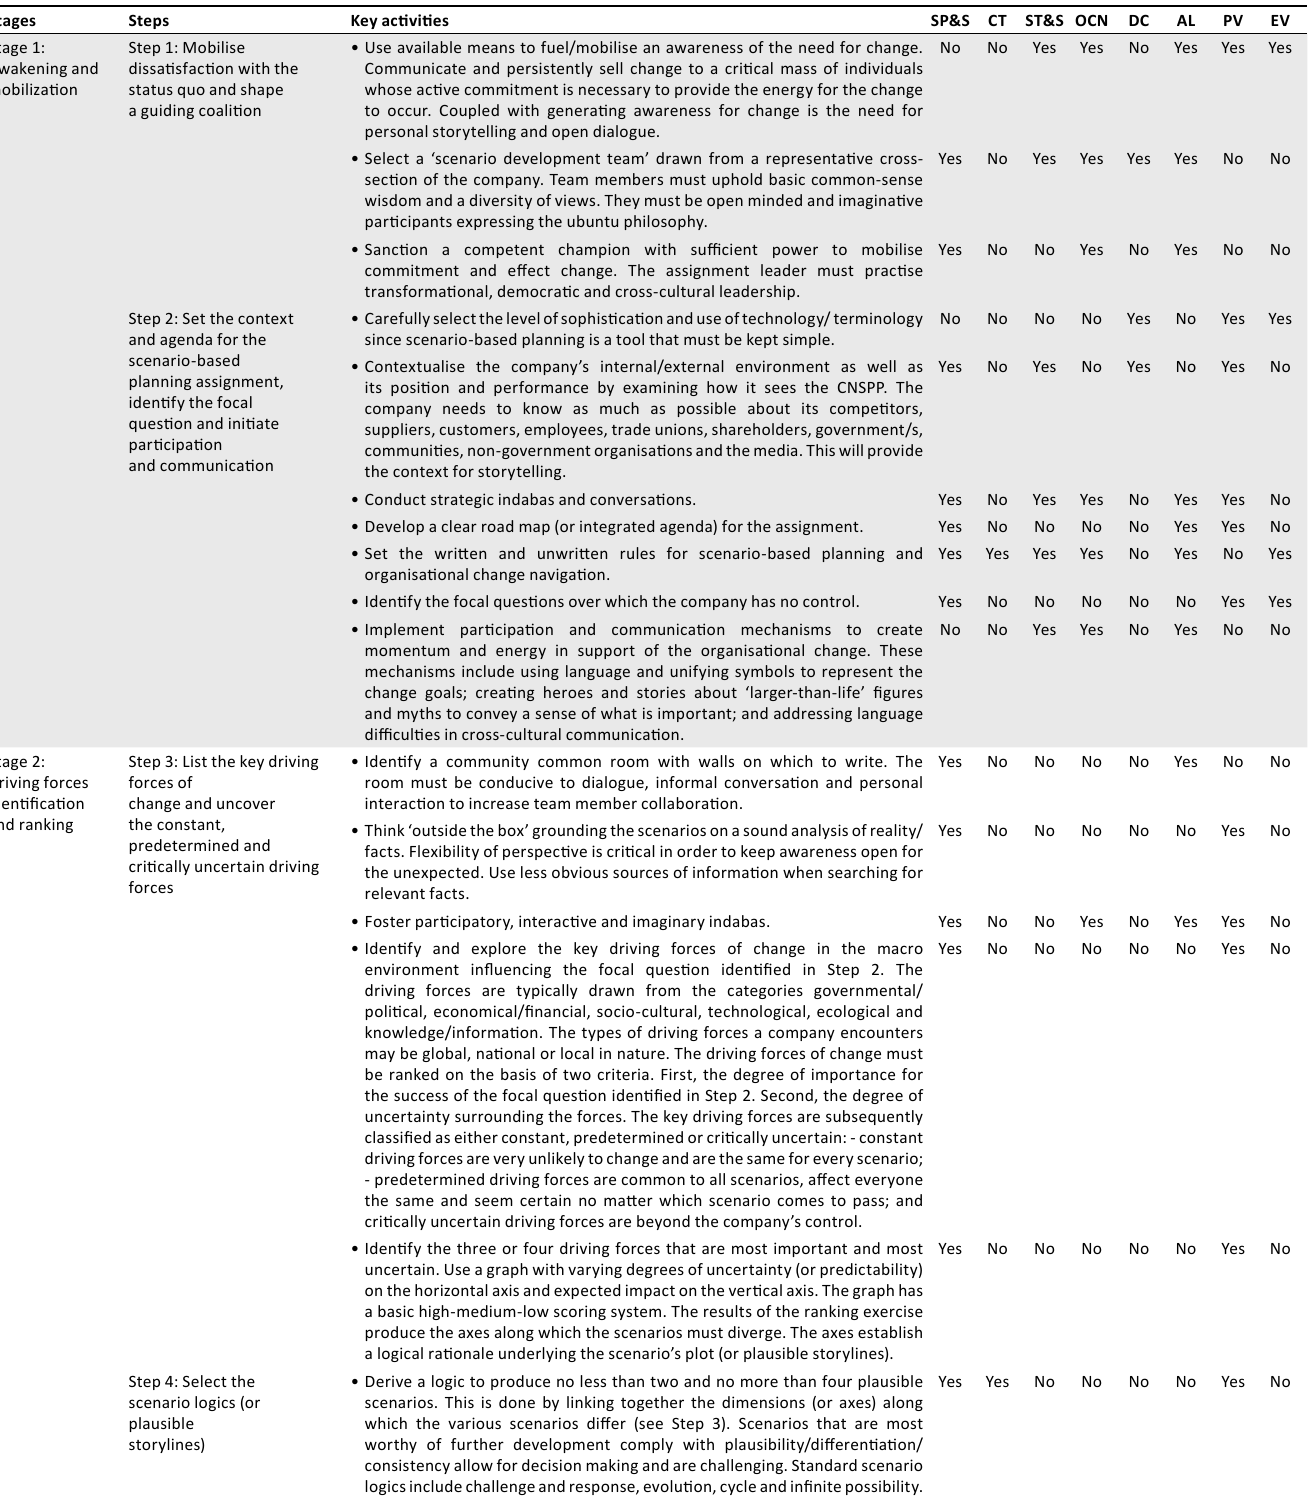
TABLE 1: A contextually aligned and empirically validated CNBSPP applicable to a developing country from an Afro-centric leadership perspective . Stages